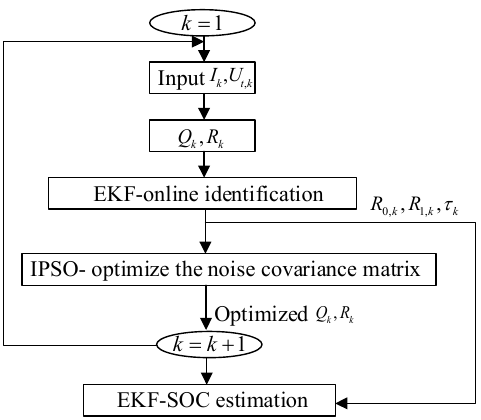
Figure 2. IPSO–DEKF algorithm schematic.